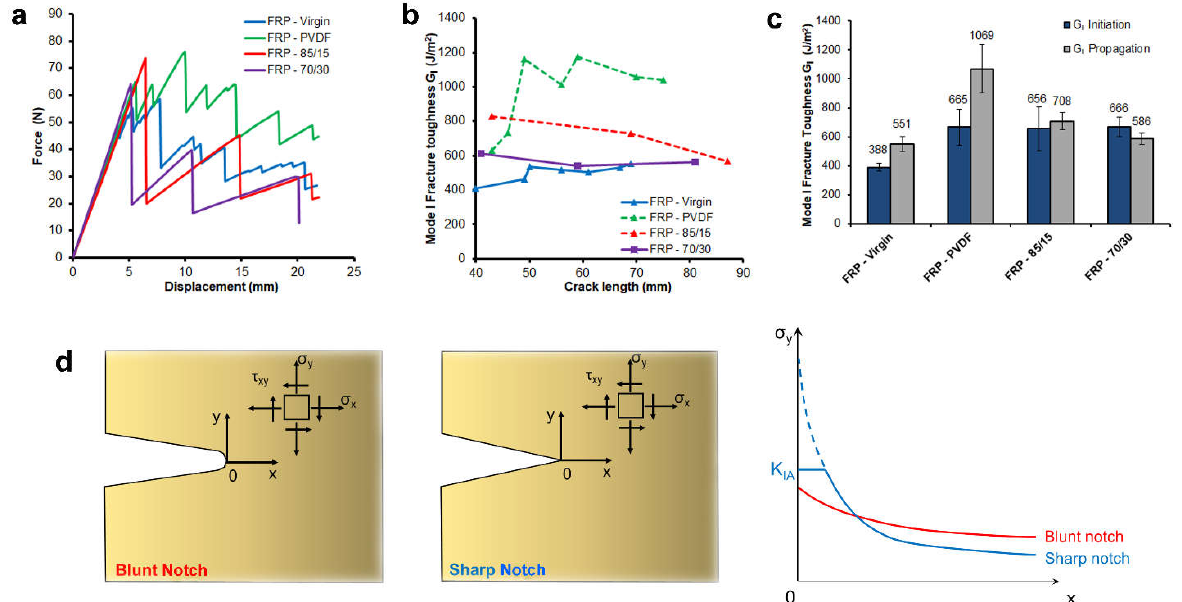
Figure 6. Delamination test results on virgin laminates and on laminates interleaved with PVDF, 85/15 and 70/30 blends: ( a ) representative force vs. displacement curves recorded during double cantilever beam (DCB) tests, ( b ) representative mode-I fracture toughness G I vs. crack length (R-curve) and ( c ) graph bar comparison of the fracture toughness at crack initiation and propagation (average between 50 and 70 mm crack length). ( d ) Geometrical effect of the notch shape (blunt vs. sharp) on the stress distribution at the crack tip.